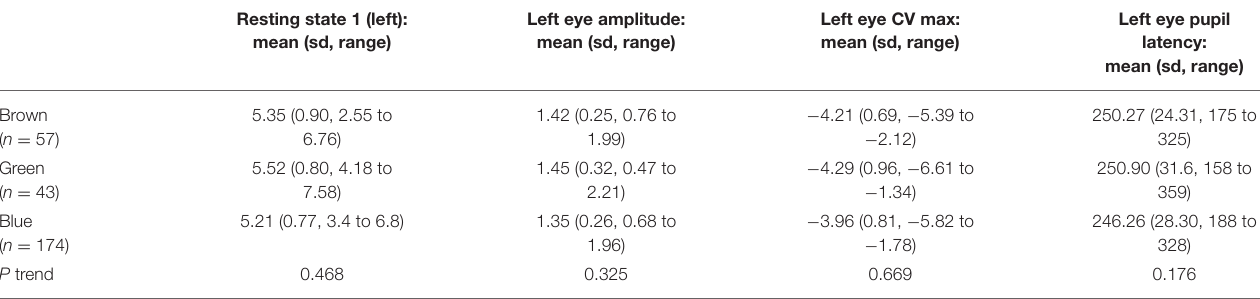
Left eye amplitude: mean (sd, range)